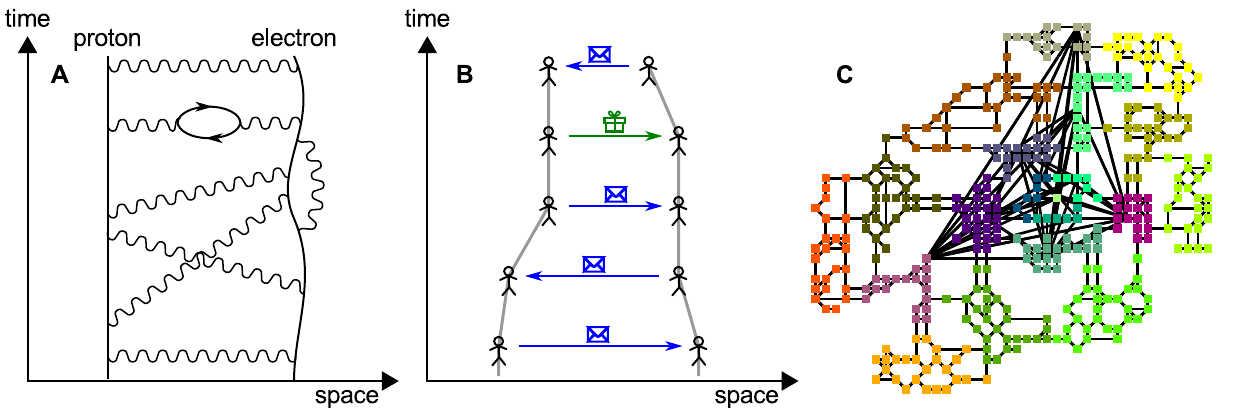
Fig 1. Interactions mediated by exchange of particles. A Electromagnetic interaction between a proton and an electron is mediated by the exchange of virtual photons (after [1]). B Two players in Pardus interact by exchanging messages and goods. C Map of the Pardus universe. Nodes are sectors (cities), lines between them are connections (streets). Colors represent different regions (countries) [2].